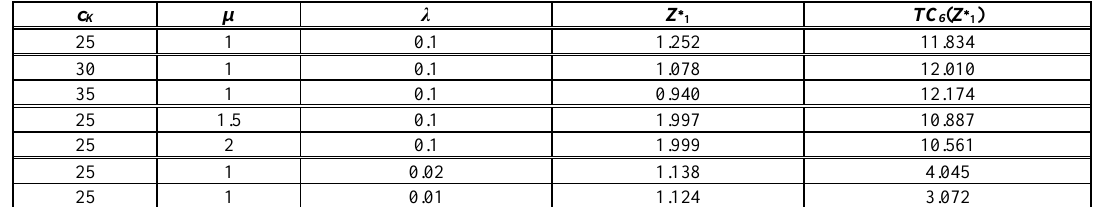
Table 6. Optimal Z ∗ 1 and TC 6 ( Z ∗ 1 ) of Model 6 for K =25, 30, 35, 𝜇 = 1, 1.5, 2 , and λ = 0.1, 0.02, 0.01 when T = 1 and L =10. µ λ